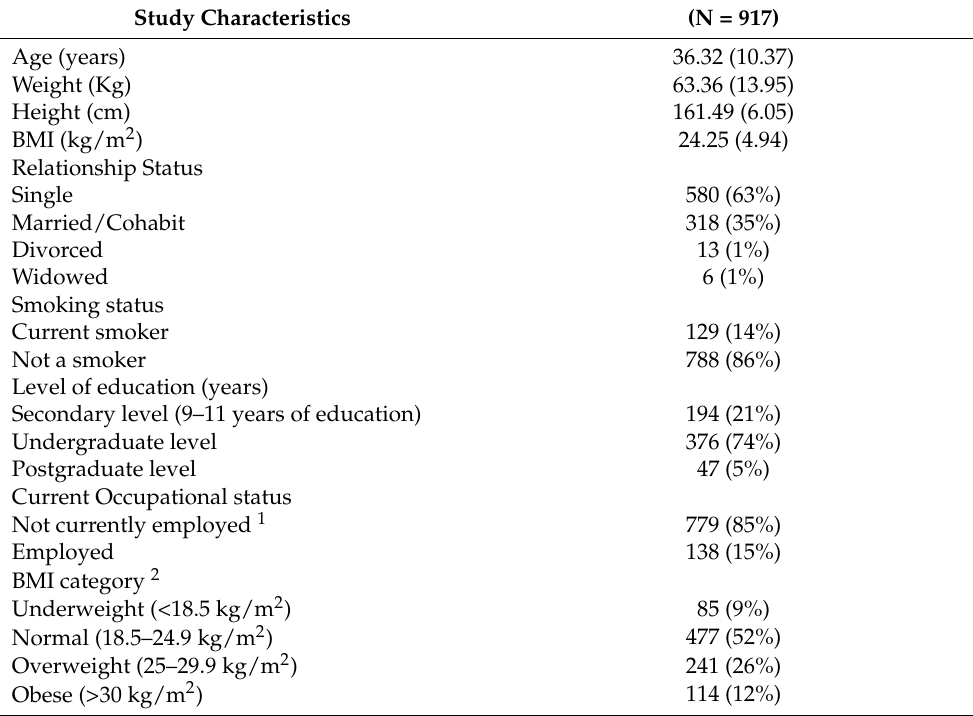
Table 1. Sociodemographic characteristic of the 917 Arabic-speaking female participants.